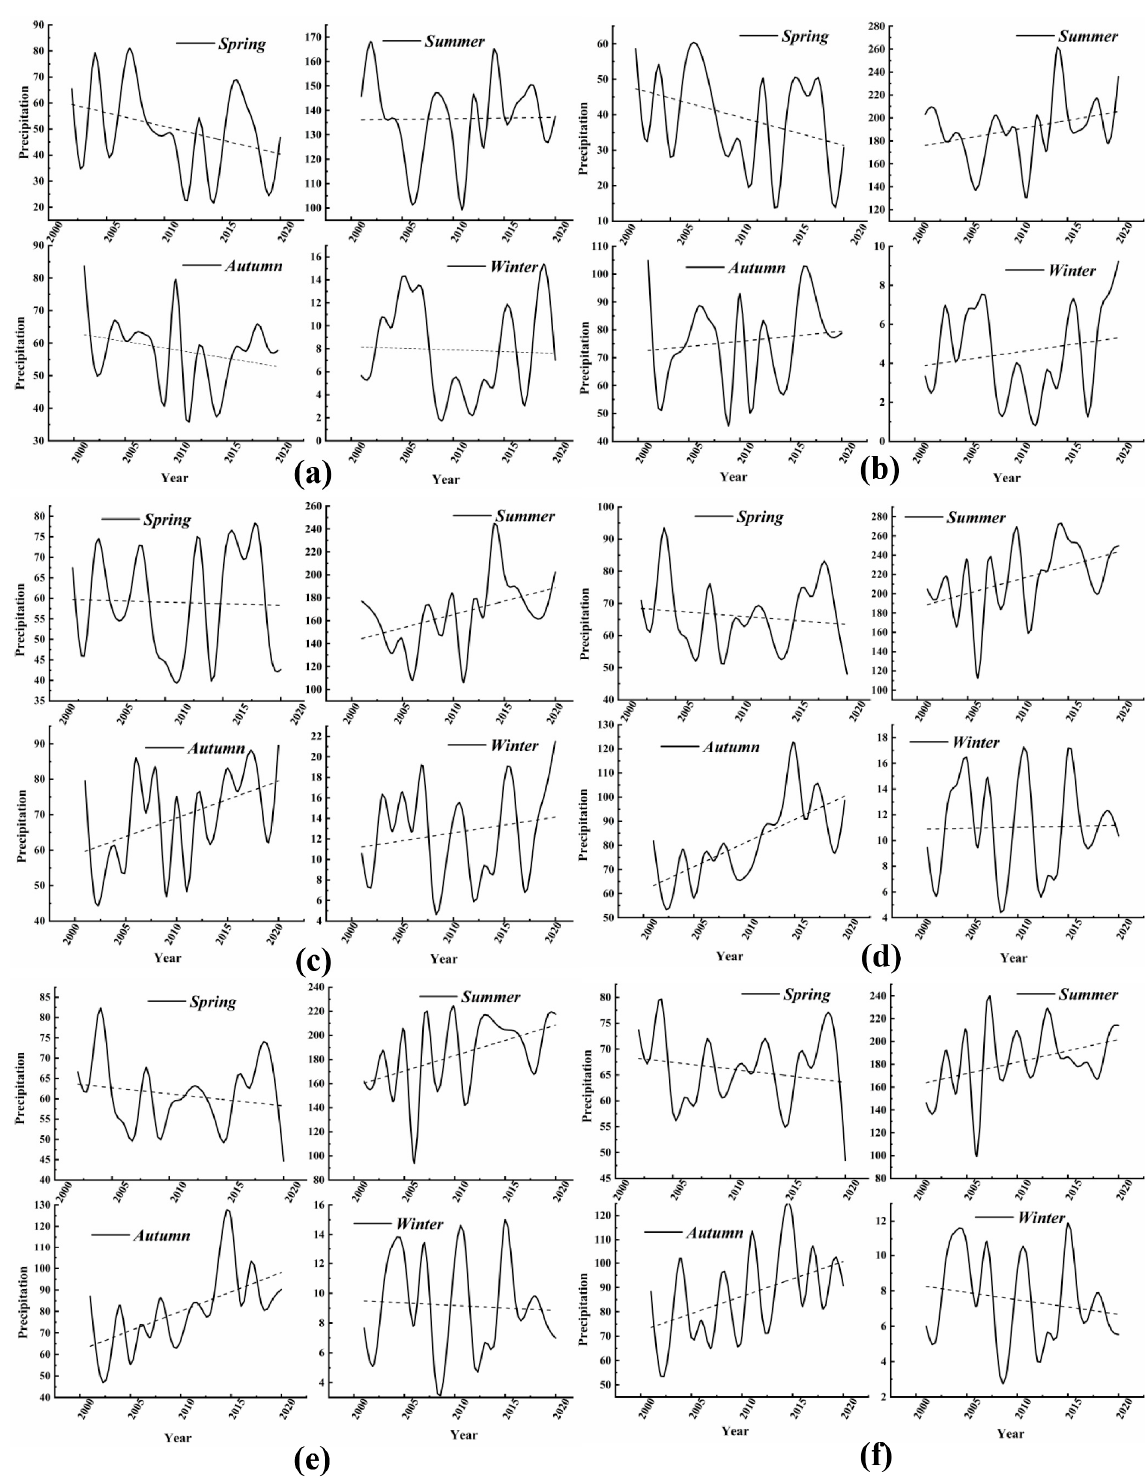
Figure 10. Seasonal characteristics of the precipitation variation in the study area (mm). ( a ) Lugu Lake; ( b ) Qionghai Lake; ( c ) Ma Lake; ( d ) Three Forks Lake; ( e ) Luban Reservoir; ( f ) Shengzhong Reservoir. Note, the direction of the dashed line indicates the trend of precipitation in spring, summer, autumn and winter.